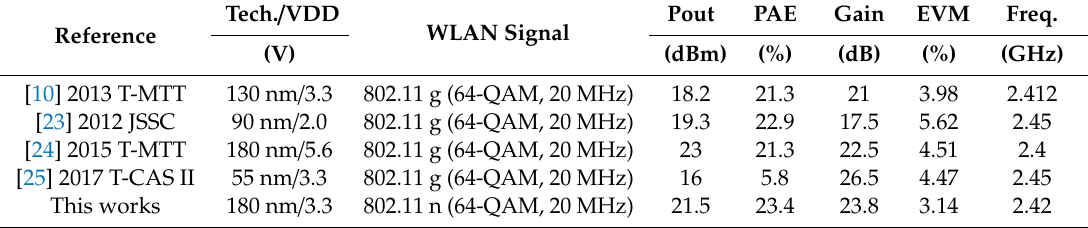
Figure 20. Measured results: PAE and gain according to output power with 802.11 n modulated signal. Table 1. Summary and Performance comparison of recent CMOS power amplifier for WLAN.